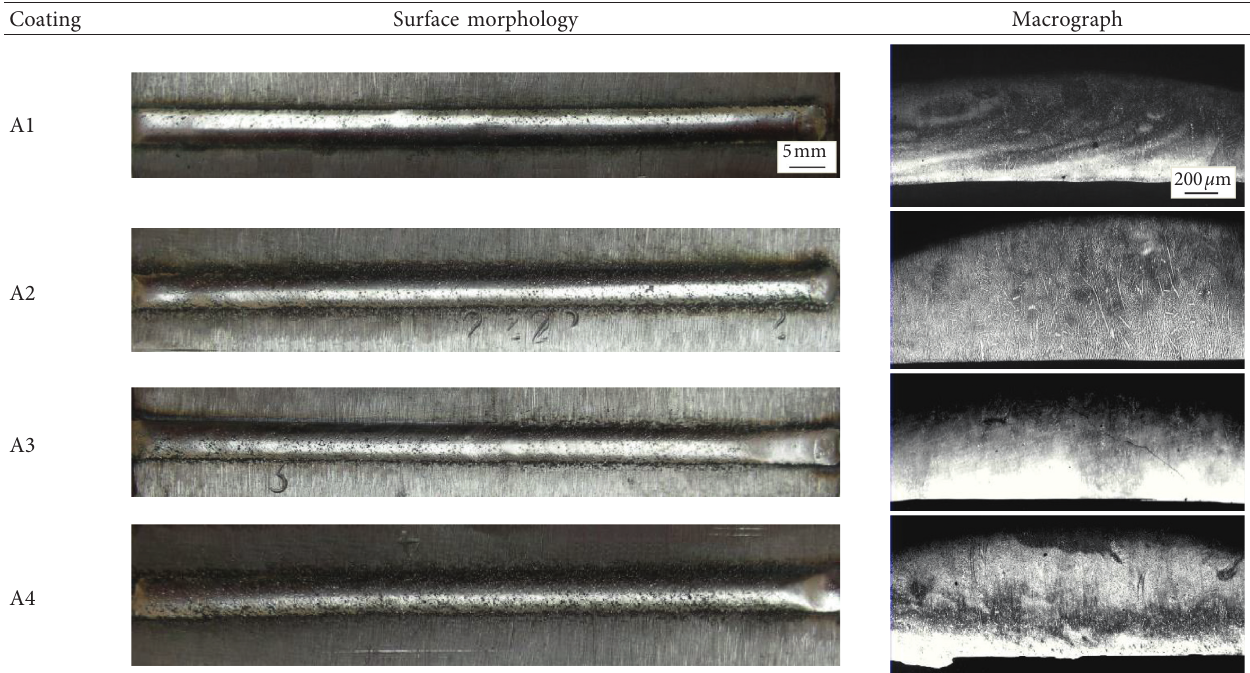
Table 3: The surface morphology and macrograph of the A group.